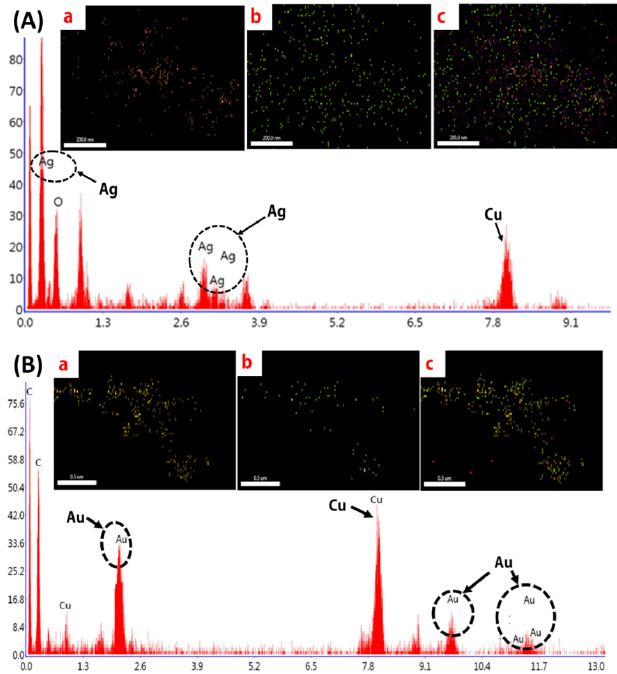
Figure 6. ( A ) EDX and elemental mapping of Ag NPs. ( a ). Uniform distribution silver NPs ( b ). oxygen, ( c ) Mixed elemental mapping of carbon, oxygen and silver NPs; ( B ) EDX and elemental mapping of Au NPs. ( a ). Gold NPs ( b ). oxygen, ( c ) Mixed elemental mapping of carbon, oxygen and gold NPs.